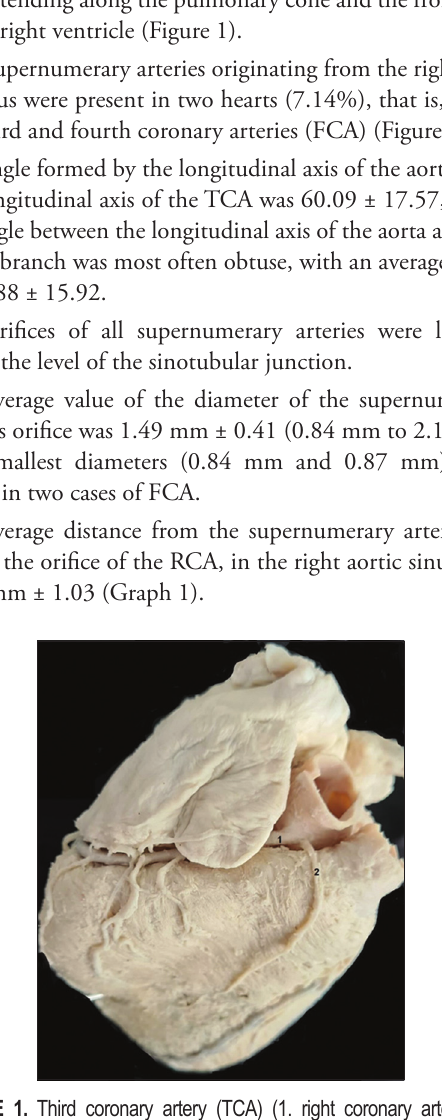
FIGURE 1. Third coronary artery (TCA) (1. right coronary artery and 2. TCA).